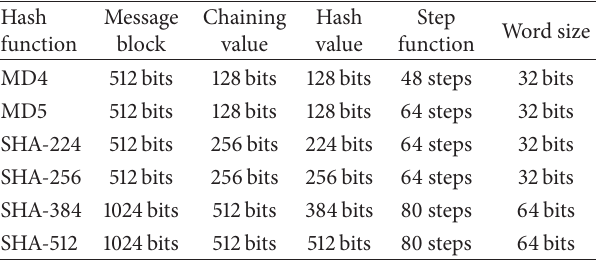
Table 2: Parameters of MD4, MD5 and